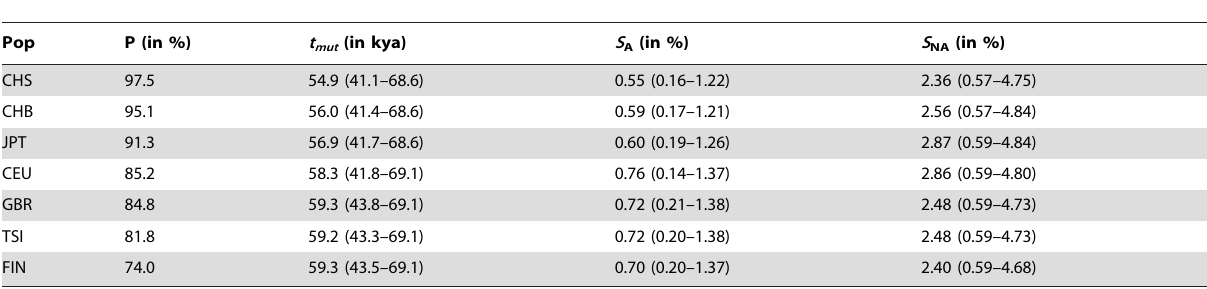
Table 3. ABC results and inferred parameter estimates for the SDN